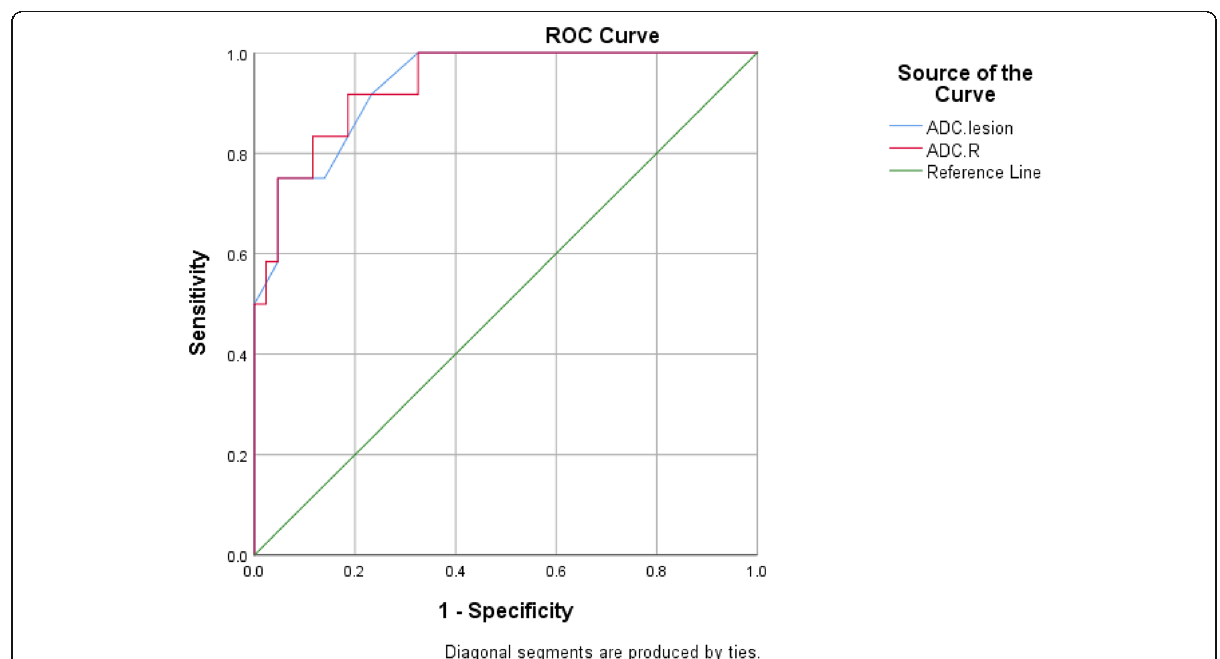
Fig. 3 ROC curves for ADC value and ADC ratio in differentiation between clear cell RCC and non-clear cell